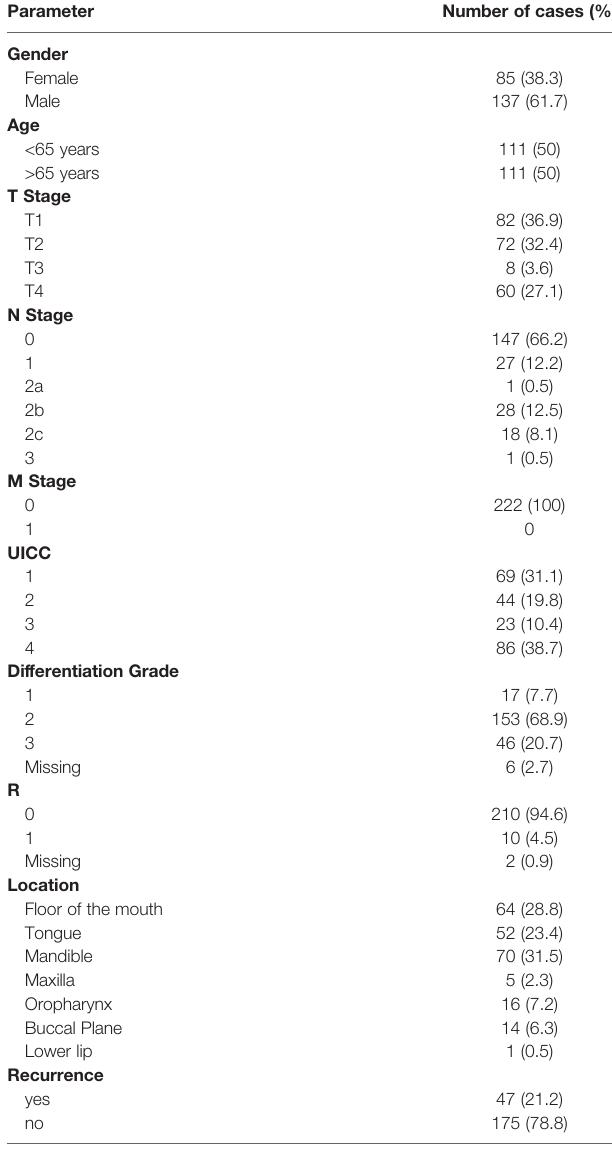
TABLE 1 | Demographic, clinical and pathological data of the investigated cohort of 222 oral and oropharyngeal cancers. Parameter Number of cases